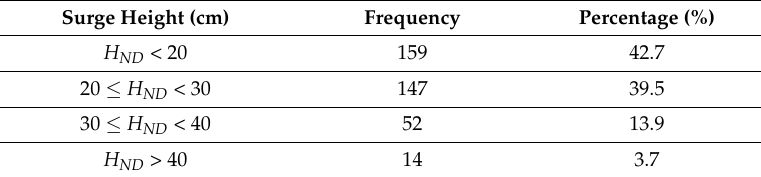
Table 1. Frequency of surge levels in Vung Tau station in 1987–2016.